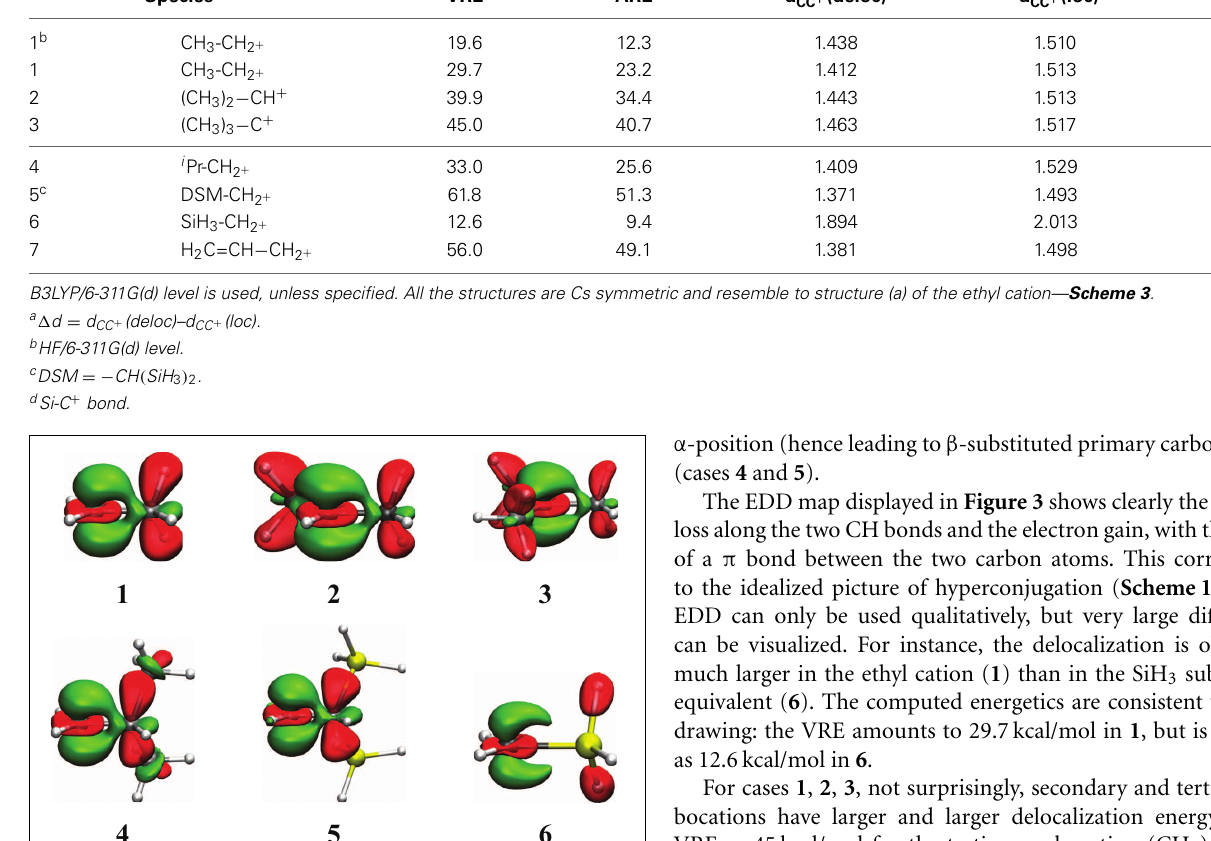
Table 2 | Hyperconjugated carbocations: vertical and adiabatic resonance energy (VRE and ARE) for the hyperconjugated systems. Species